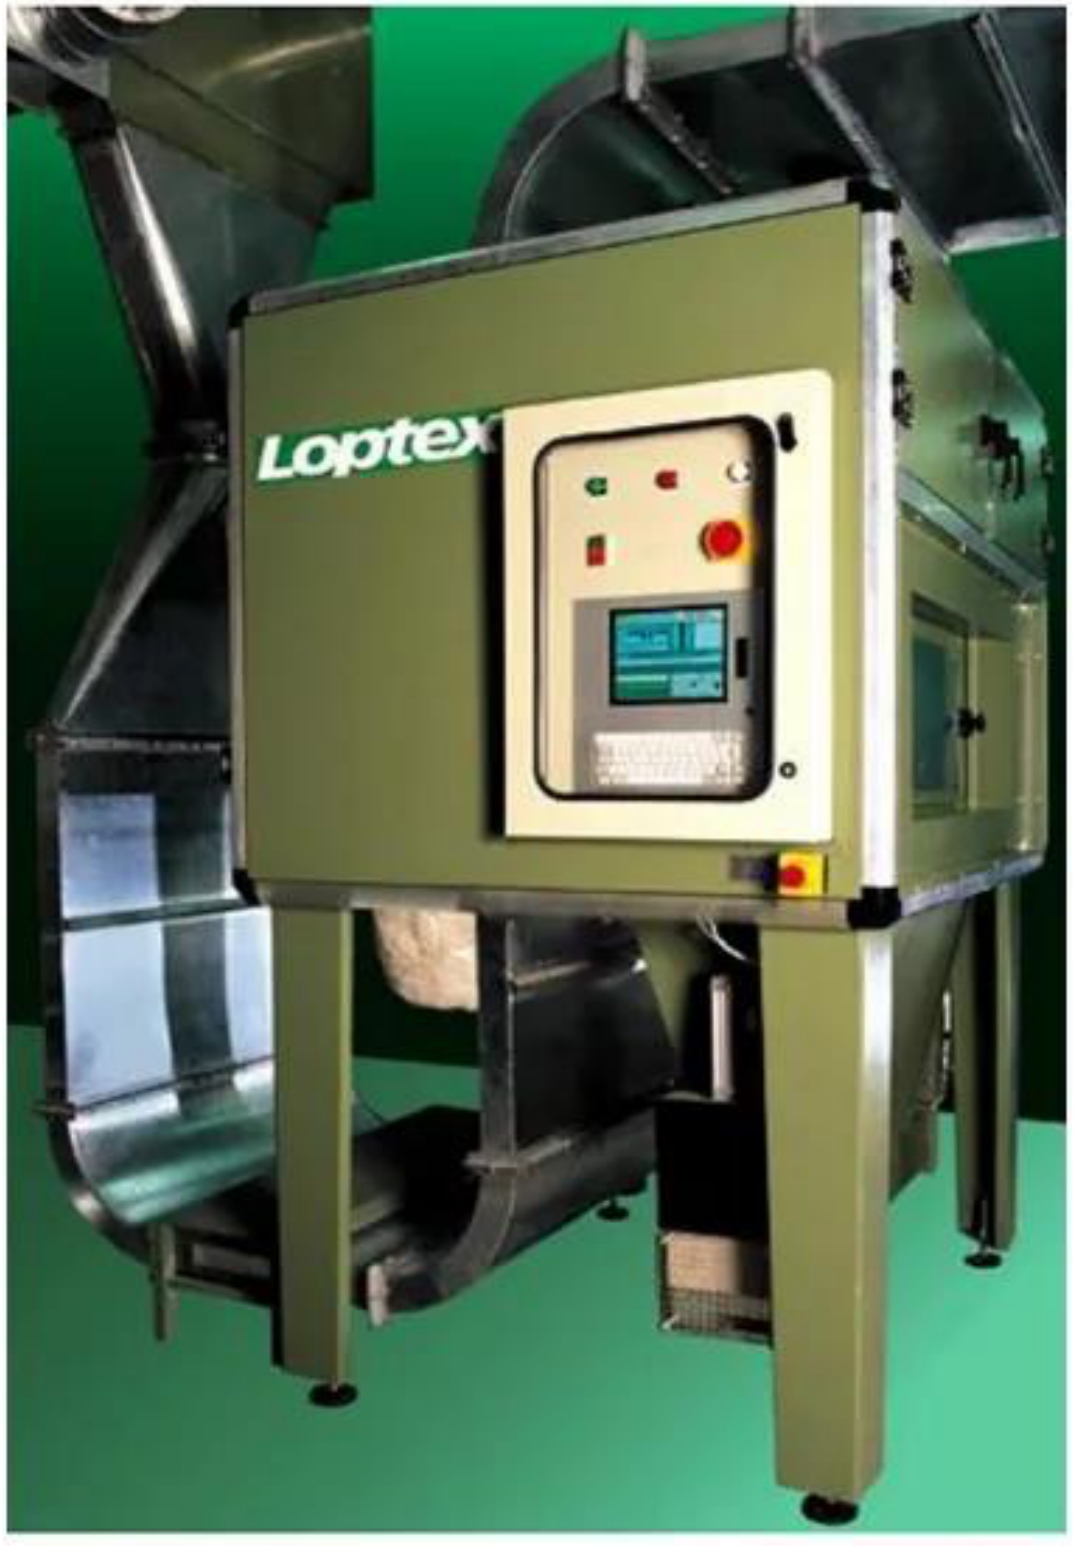
Figure 6. Example Loptex sorter that uses both optical and ultrasonic sensors (adopted with permission from [95]).